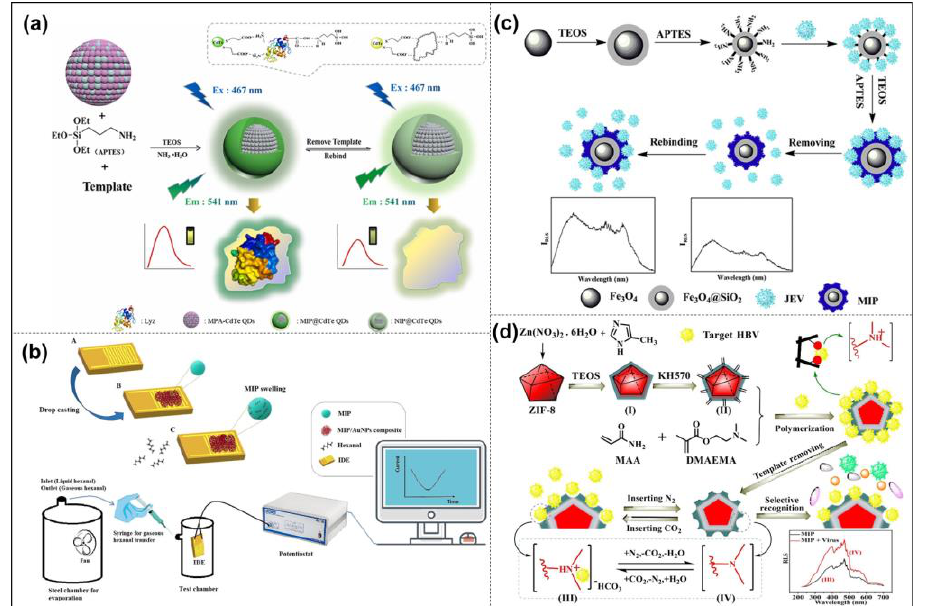
Figure 9. Schematic diagram of the synthesis of MPA-CdTe QD-embedded MIPs ( a ); a conductive nanocomposite of MIPs and AuNPs for detection of lung cancer ( b ); synthesis of magnetic Fe 3 O 4 nanoparticles, silica-modified Fe 3 O 4 nanoparticles, functionalized Fe 3 O 4 @SiO 2 microspheres, virus- imprinted magnetic microspheres, and non-imprinted microspheres ( c ); preparation of MIP-NPs and principle of HBV recognition ( d ). Reprinted with permission from Refs. [110,130,131,134]. Copyright 2020, Elsevier; 2022, Elsevier; 2019, Elsevier; 2022, Elsevier.